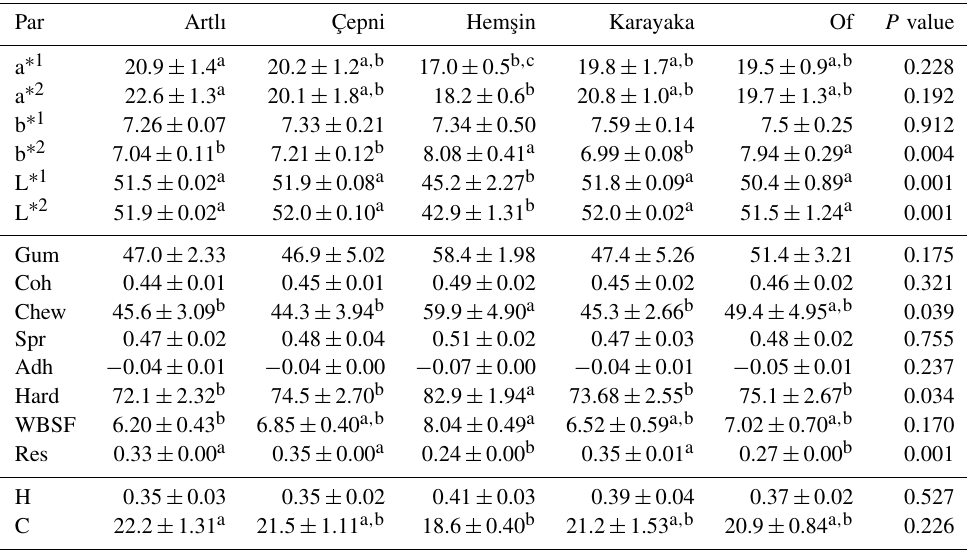
Table 2. Instrumental meat quality characteristics in five local lamb breeds ( n = 10). Par Artlı Çepni Hem¸sin Karayaka a ∗